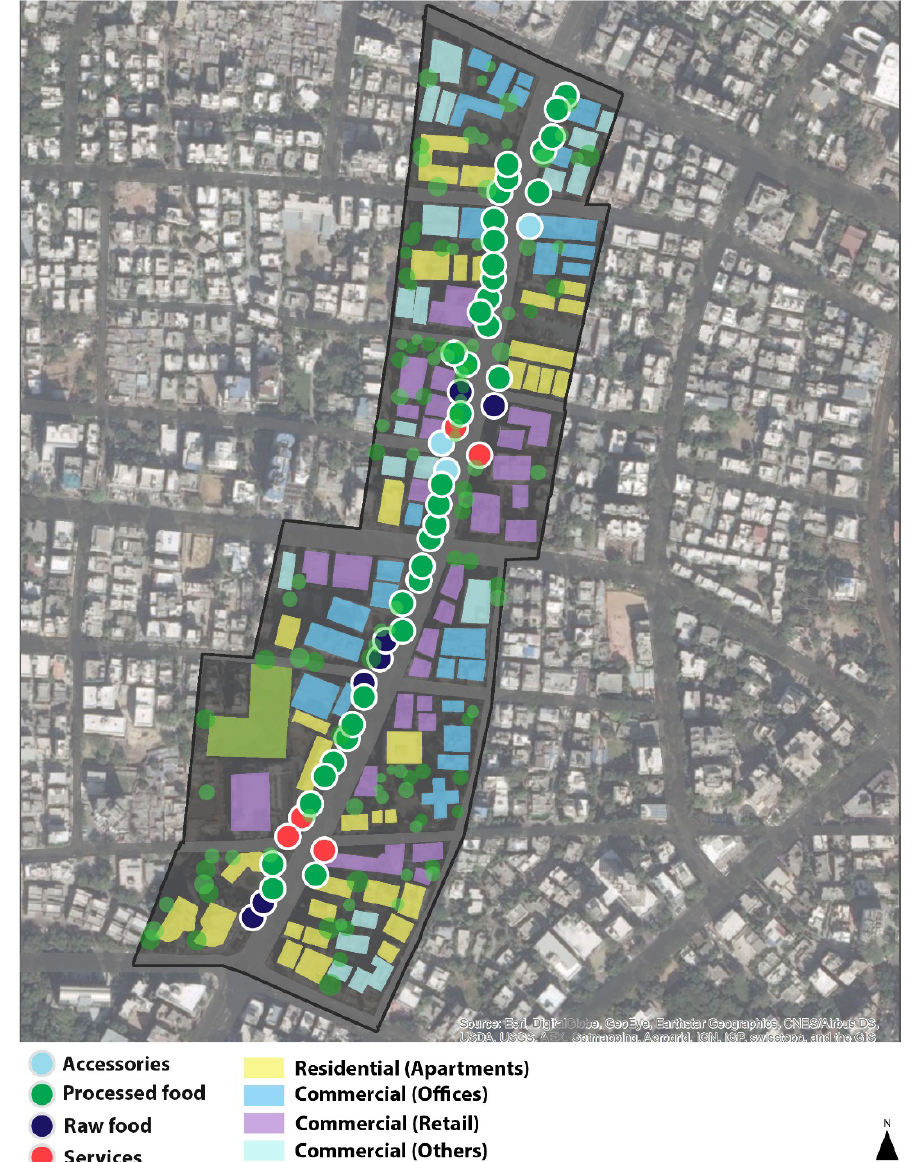
Figure 7. Street market at C.G. Road. Source: Field work. PPS’ Place Diagram Tool indicates how diverse ac- tivities can offer greater opportunities to engage with the public space and retain a higher volume of